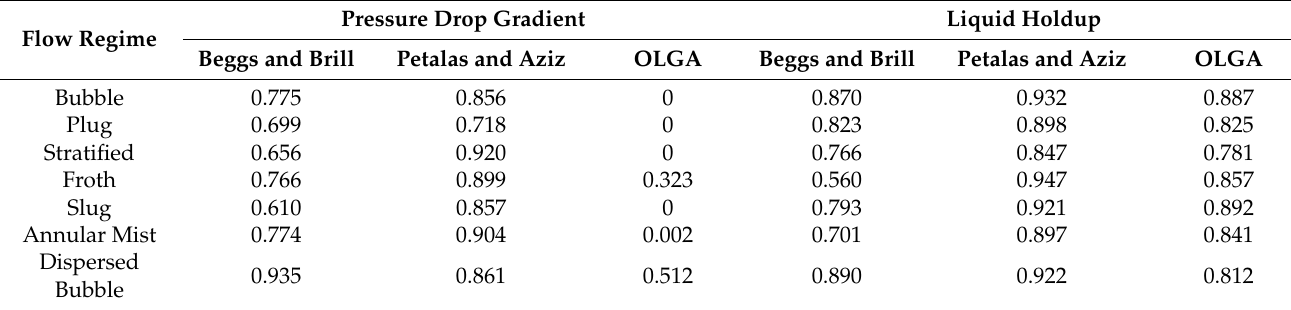
Table 1. R 2 values for the steady-state multiphase flow models vs. Stanford dataset.